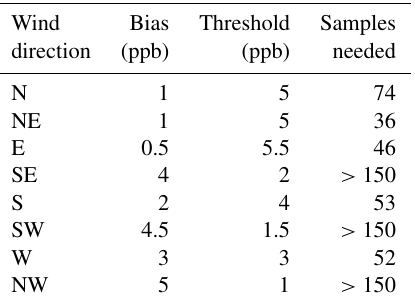
Figure 5. Average of the differences between criteria 2 and 1 CH 4 backgrounds at Indianapolis as a function of wind direction. These averages are generated from the same data that are used in Fig. 4 and reflect results shown in Fig. 4g. Error bars indicate in (a) 2 times the standard error and in (b) 2 times the standard deviation. Table 2. A number of independent samples needed (column 4) to satisfy the combined requirement of 6ppb background error based on the sum of bias and random error (explained in Sect. 3.2) as a function of wind direction.